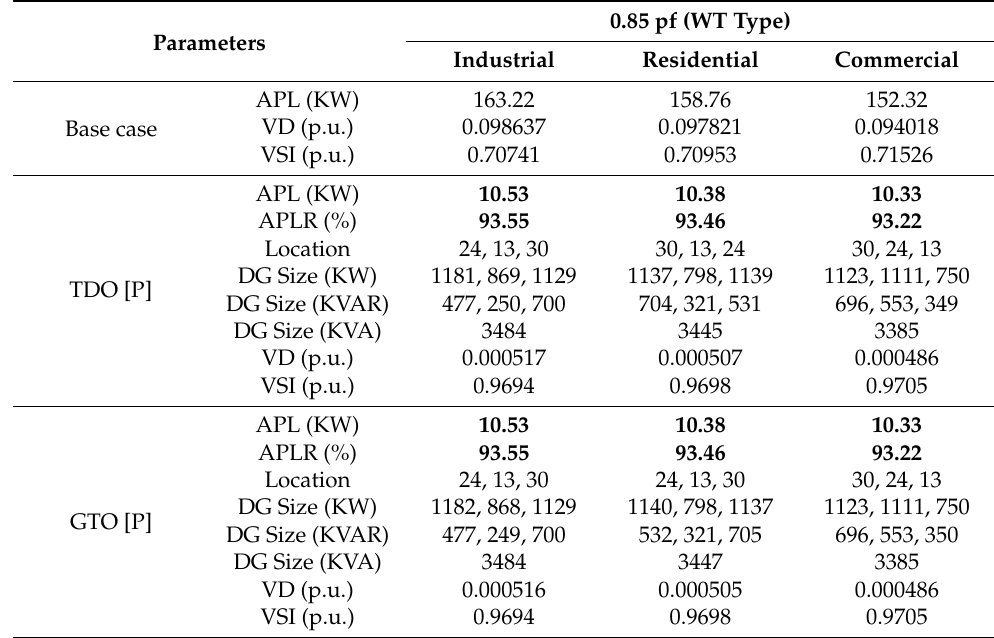
Table 7. Results of the OADG for a 33-bus RDN for SOP (APL minimization) at 0.85 pf (WT type) in the VP load